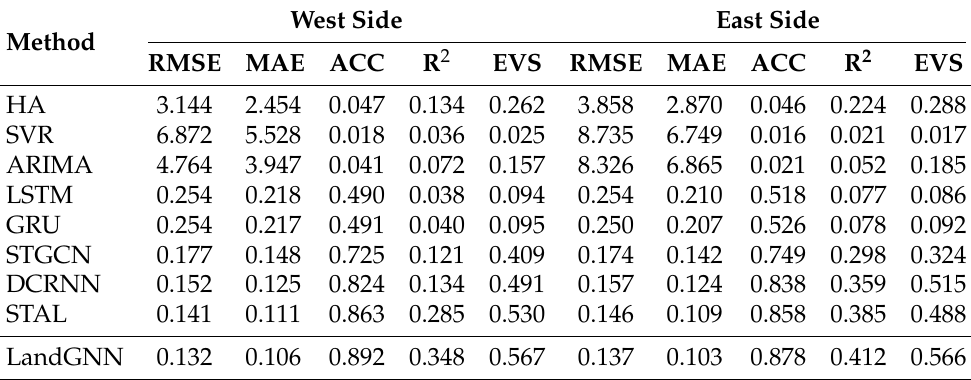
Table 2. Performance comparison of displacement prediction on both sides of the river. For RMSE and MAE, the lower the value, the better the performance. Conversely, higher values are desirable for ACC, R 2 and